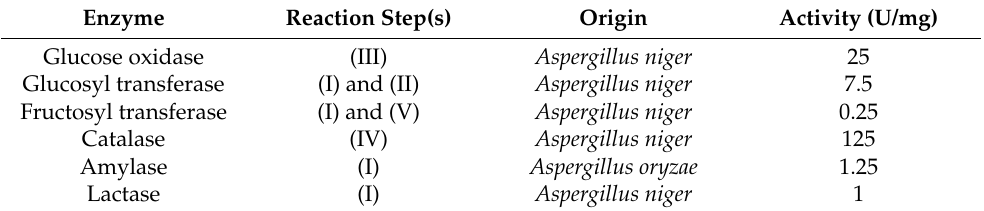
Figure 1. Schematic representation of the activities of the enzymes contained in the enzyme mixture evaluated in this study. Carbohydrates are converted to indigestible oligosaccharides by the various enzymes. Table 1. The origins and activities of the enzymes contained in the enzyme